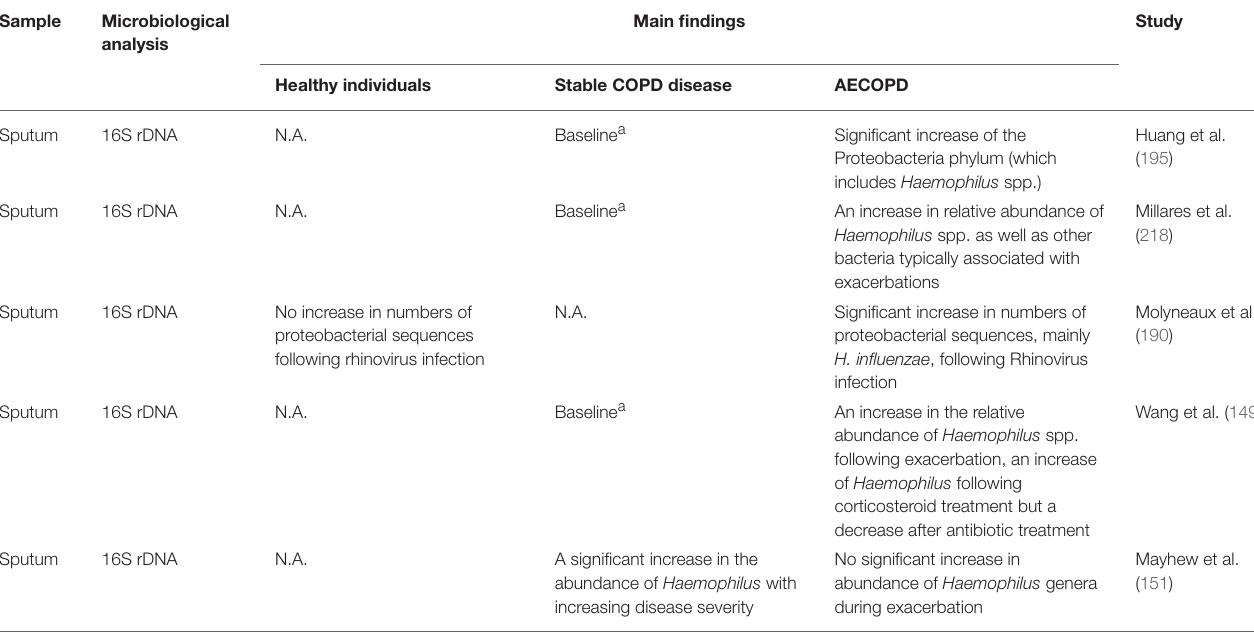
TABLE 2 | Abundance and significance of NTHi and other potentially pathogenic bacteria in healthy individuals and various stages of COPD using molecular methods.